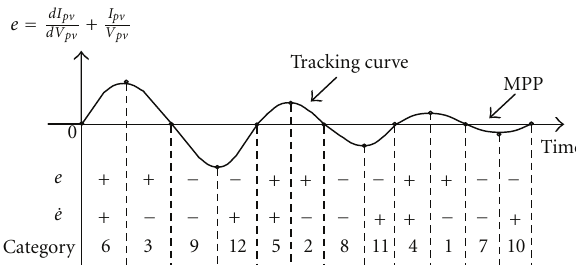
Figure 5: Dynamic slope analysis diagram of I - V characteristic